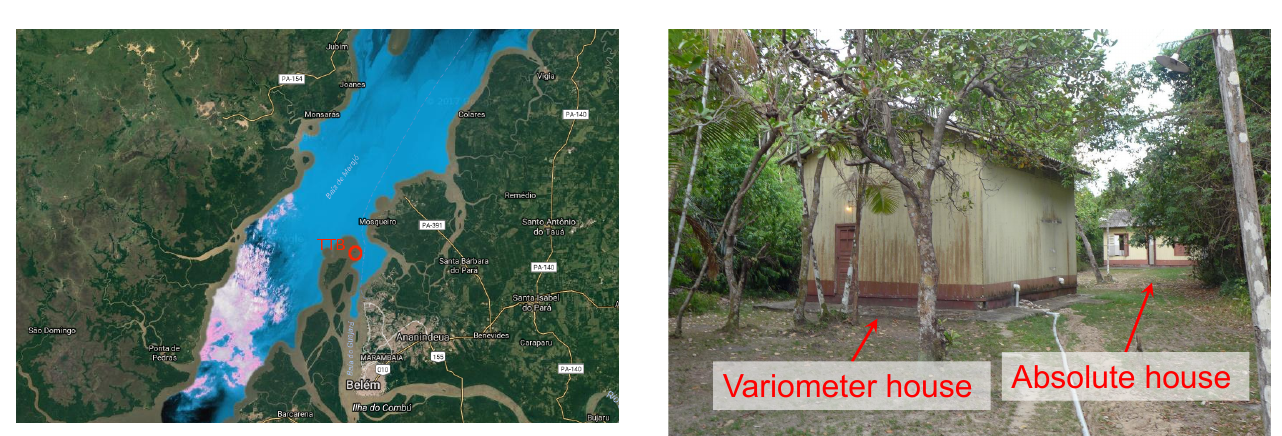
Figure 4. The variometer and absolute houses of Tatuoca observa- tory are shown. These are located at the north-eastern corner of the island (Fig.